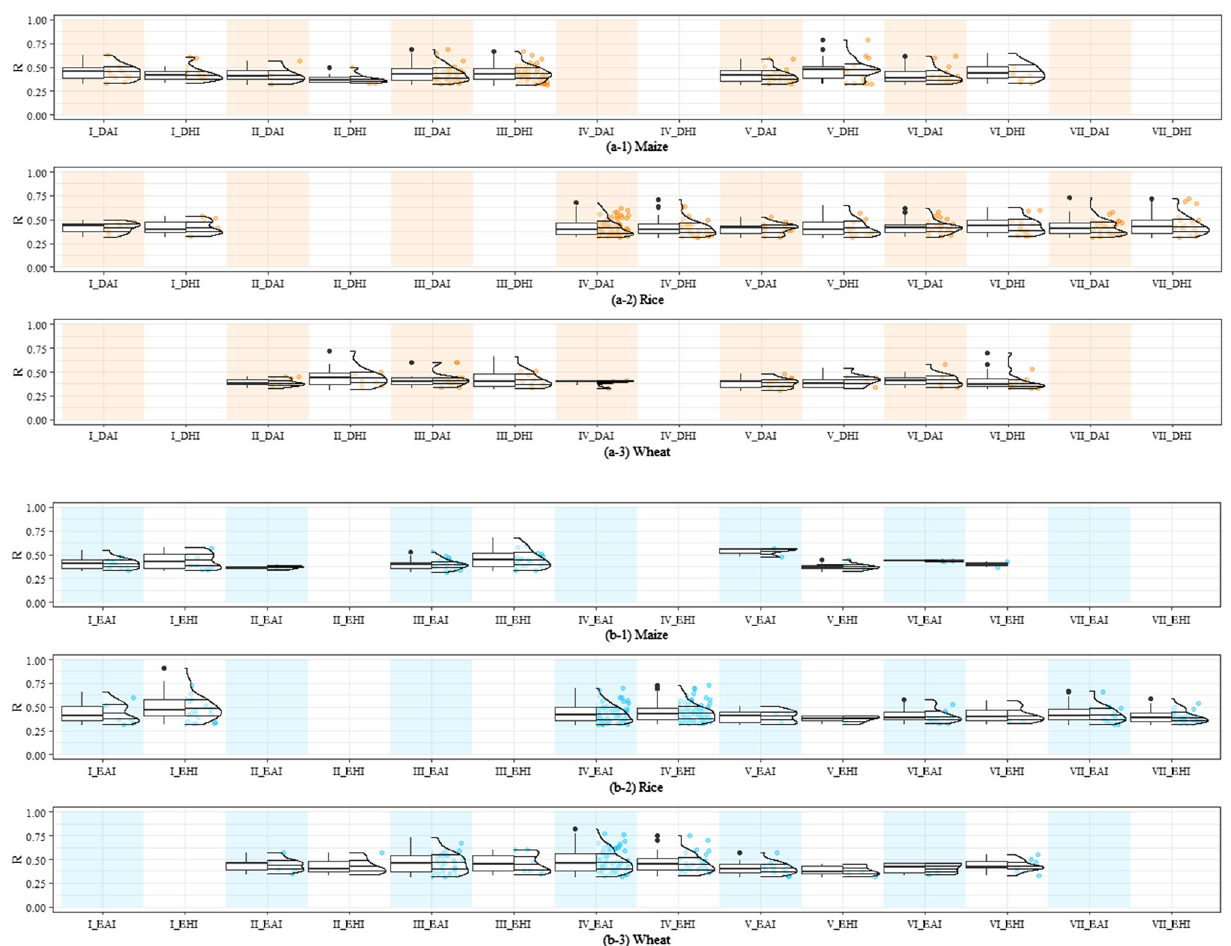
Fig. 5 Boxplots and kernel density curves of Pearson R for: a deficit rain and b excessive rain. The y axis refers to the Pearson R value. Combinations of agricultural zone ID (see Table 1) and weather index (see Table 2) are on the x axis. The odd columns with colored shadow